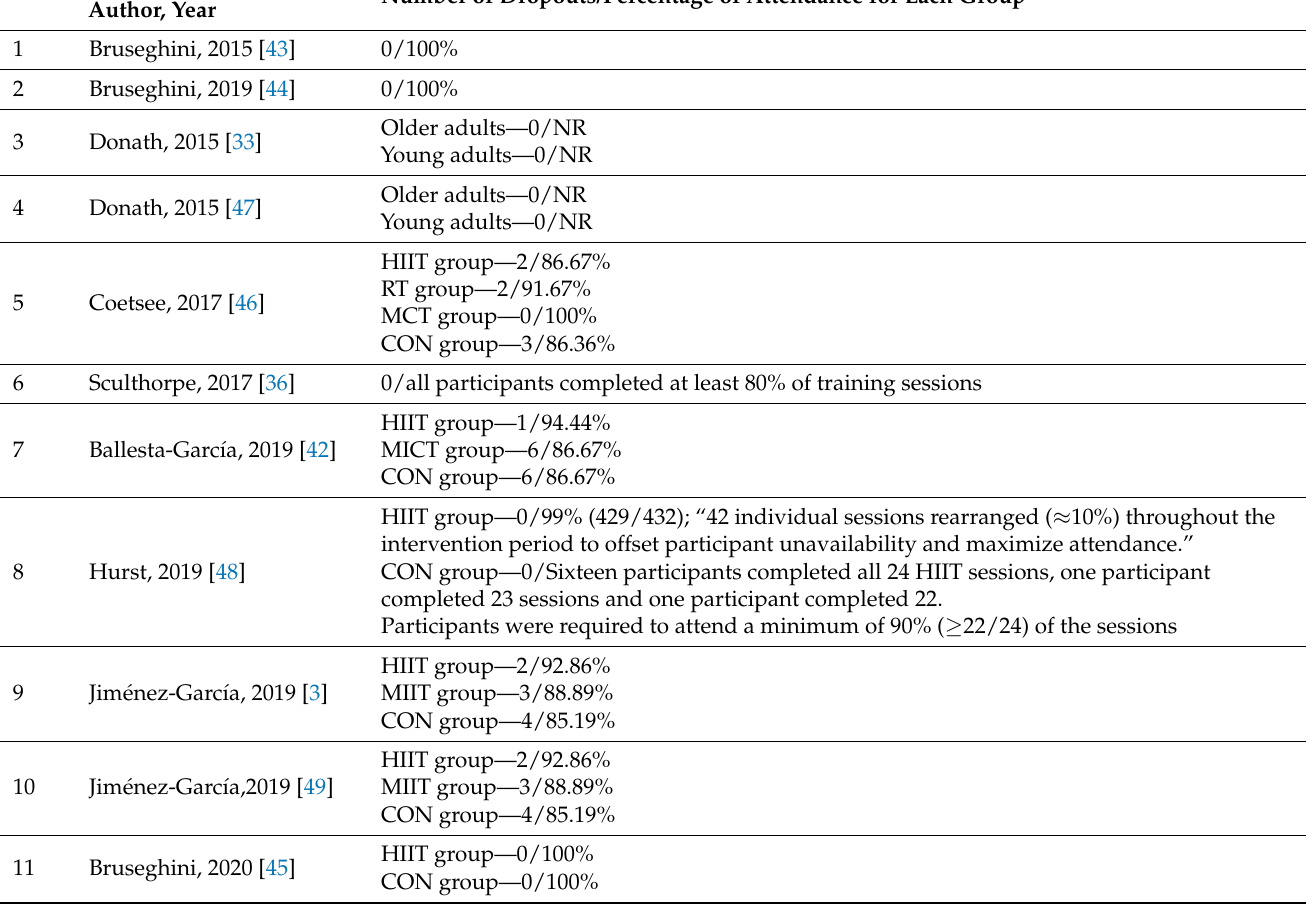
Table 4. Number of dropouts and percentage of attendance for each study